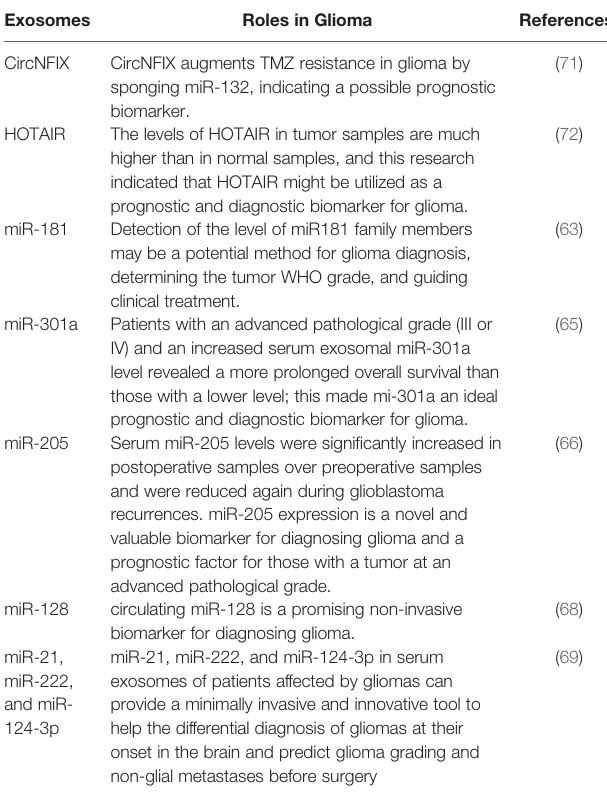
TABLE 2 | Various available exosomes considered as biomarkers for